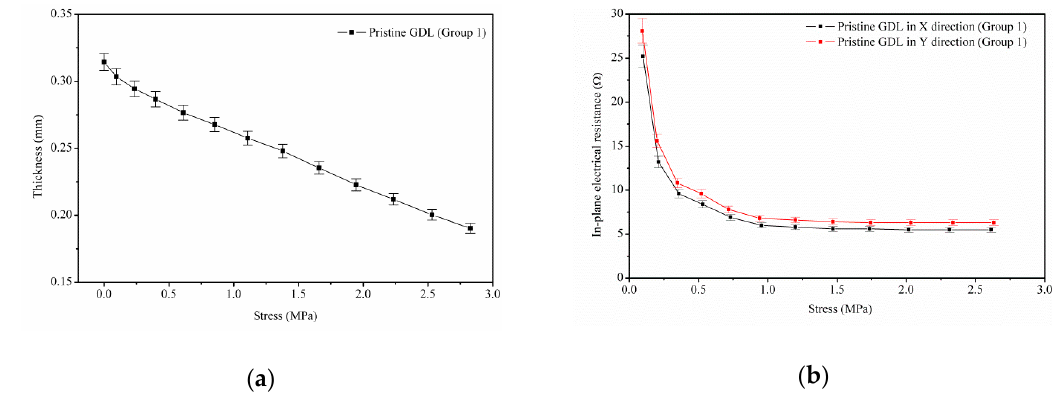
Figure 5. Test data of fresh GDLs: ( a ) Thickness vs. stress; ( b ) in-plane electrical resistance vs. stress.